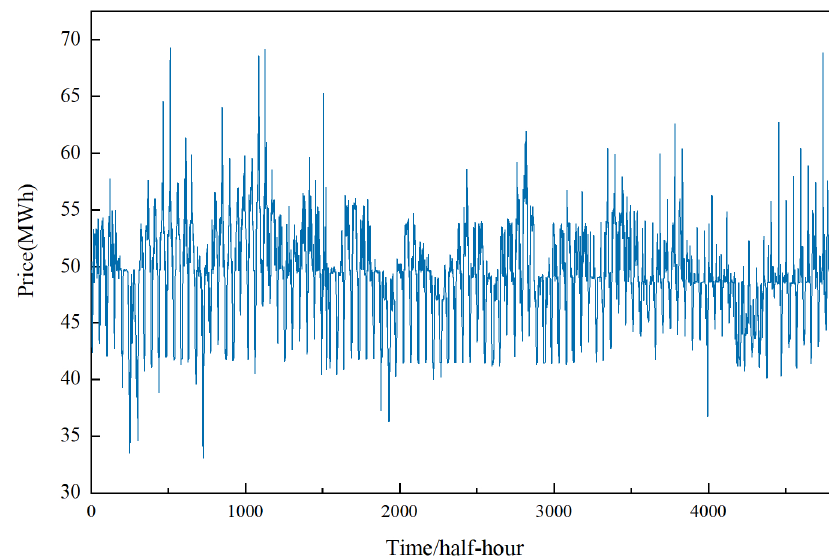
Figure 3. Original electricity price series.